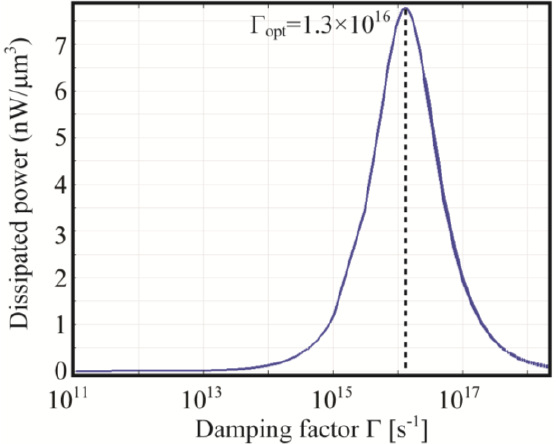
Figure 4. Dissipated power for a 10 nm radius Au NP in air over a wide range of Γ values at a given incident frequency: ω dissipated power is